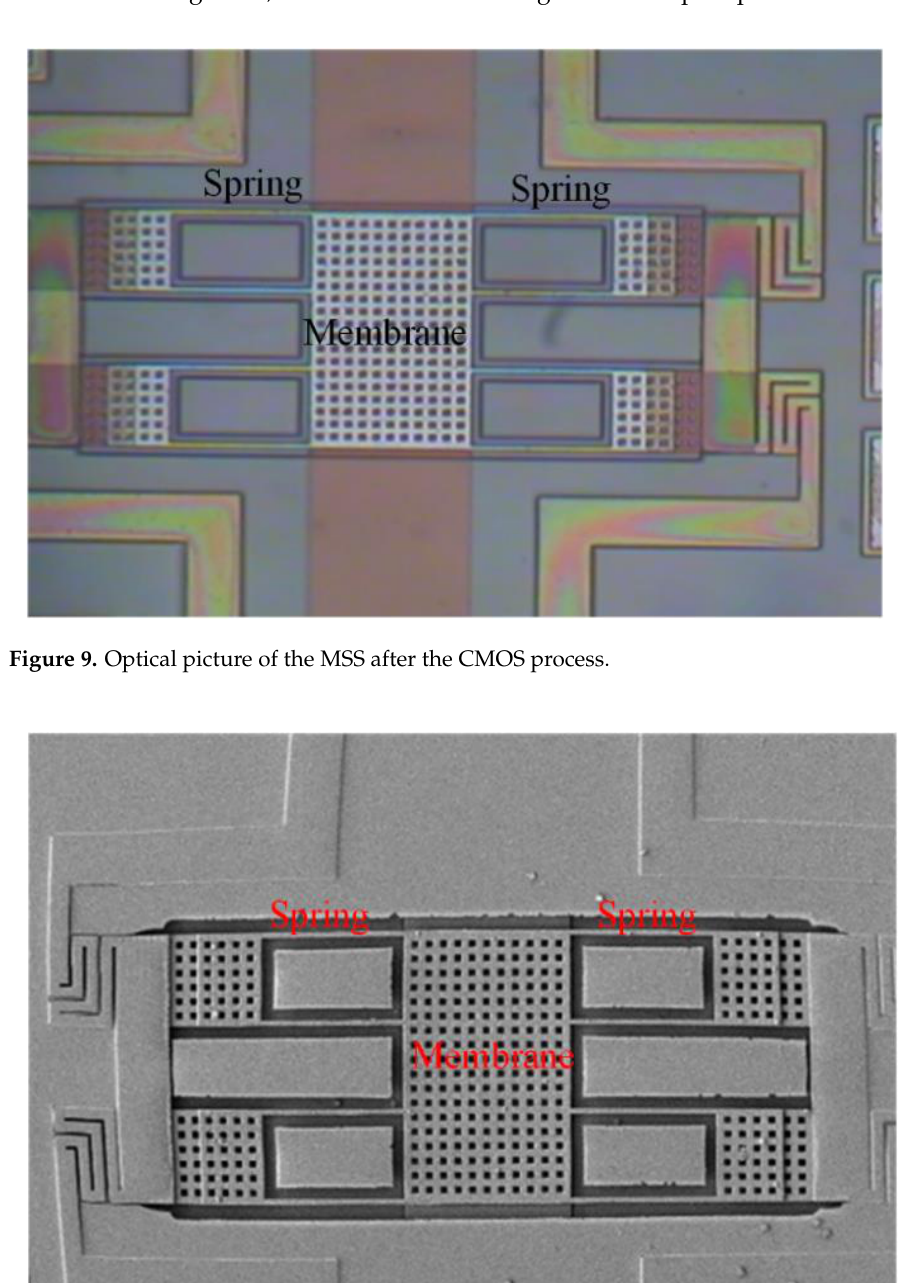
Figure 8. Process flow of the MSS: ( a ) after the complementary metal oxide semiconductor structures. Figure 11 shows the SEM picture for the suspension membrane. The membrane (CMOS) process; and ( b ) etching oxide layer. had some etching holes, which decreased etching time in the post-process.